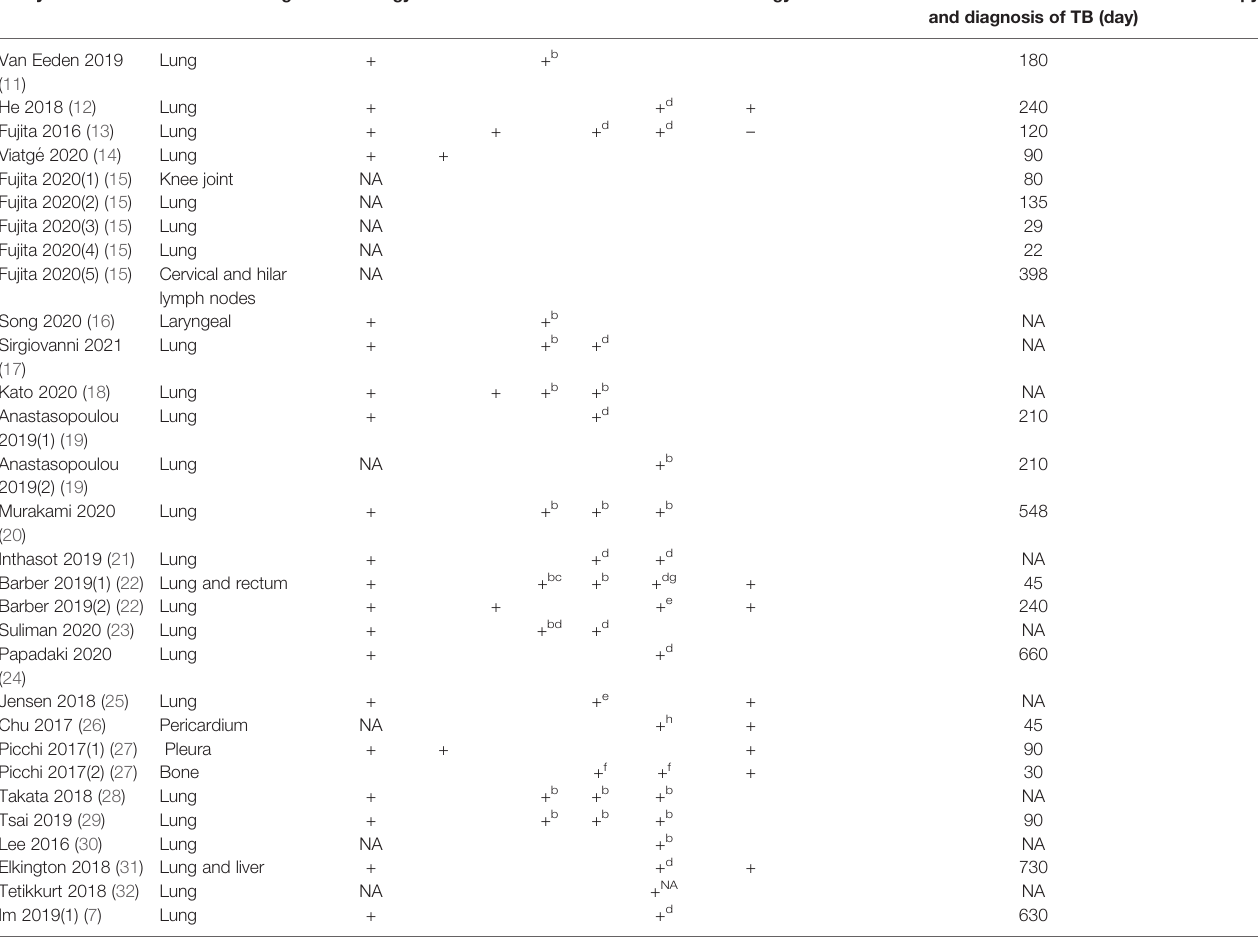
TABLE 2 | Detailed clinical data of TB patients included in this study.